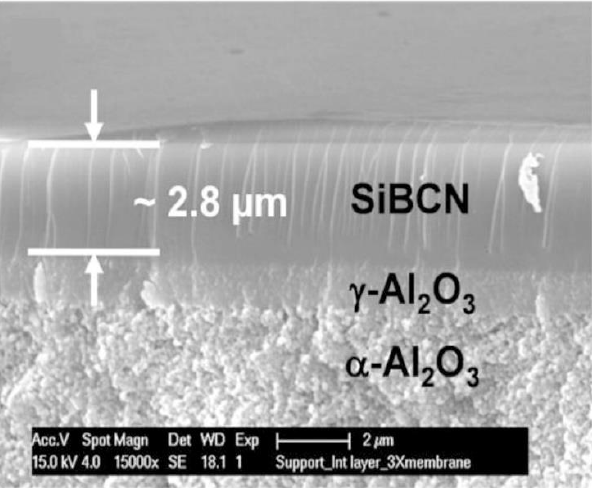
Figure 22. Cross section of a multilayer Si – B – C –N/γ -Al 2 O 3 /α -Al 2 O 3 membrane. Adapted from [107] with permission from John Wiley and Sons. with permission from John Wiley and